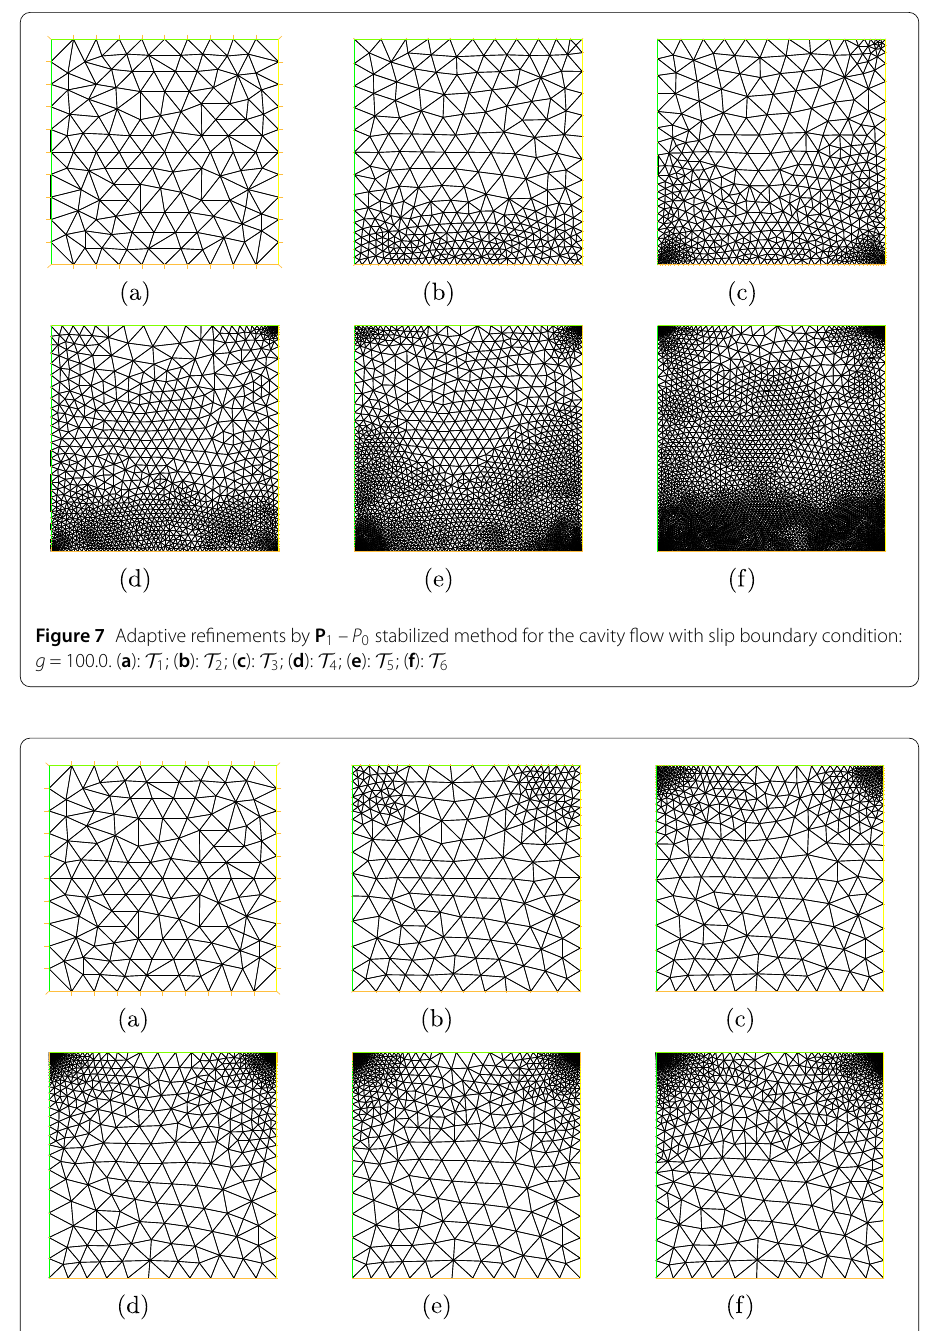
Figure 8 Adaptive refinements by P 1 – P 1 stabilized method for the cavity flow with slip boundary condition: g = 1.0. ( a ): T 1 ; ( b ): T 2 ; ( c ): T 3 ; ( d ): T 4 ; ( e ): T 5 ; ( f ): T